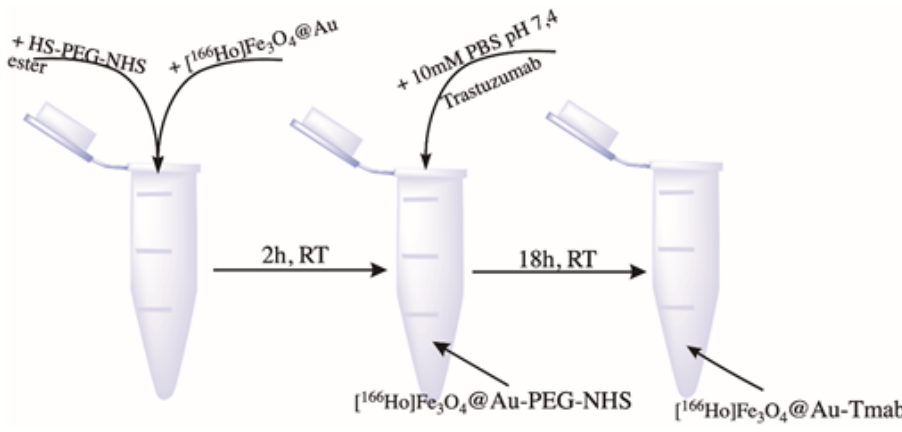
Figure 3. Scheme of [ 166 Ho]Fe 3 O 4 coating with